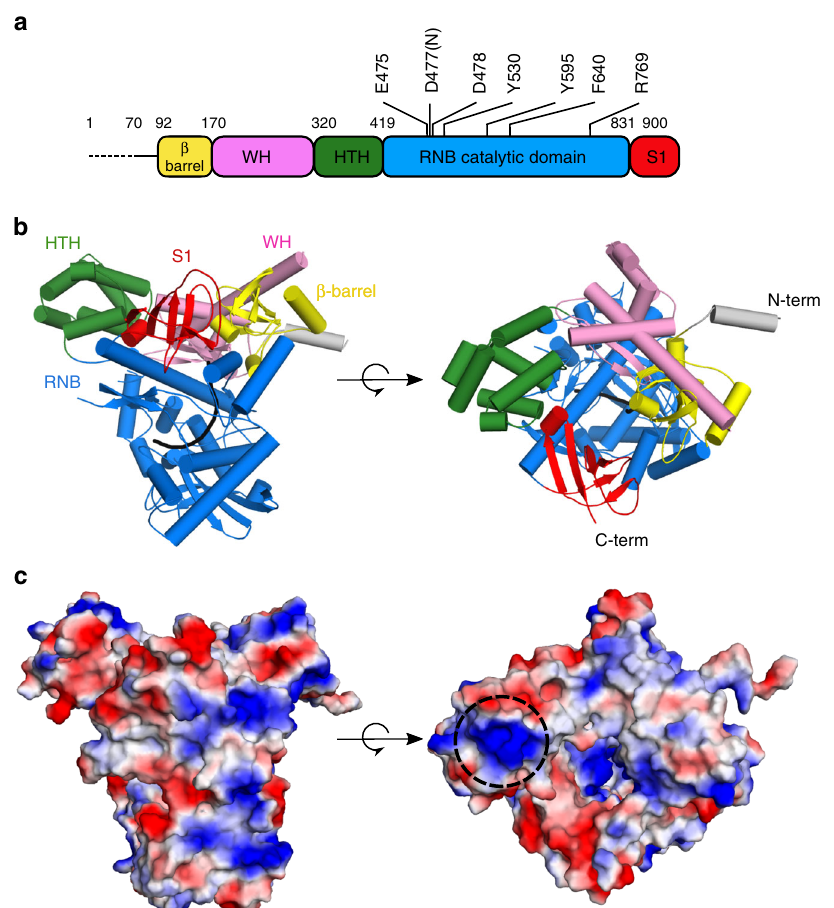
Fig. 1 Crystal structure of C. glabrata Dss1 70 – 900 D477N. a Schematic of the domain composition of Cg -Dss1. The domains are shown in colors: β -barrel in yellow; WH (wing-helix) in pink; HTH (helix-turn-helix) in green; RNB (nuclease domain) in blue; S1 in red. The dashed line corresponds to the region deleted in the crystallized variant. The positions of the residues of the RNB domain that are involved in RNA binding and degradation are indicated. b Overall structure of Cg -Dss1 70 – 900 D477N. The domains are colored as in a . The co-crystallized RNA molecule is shown in black. c Electrostatic surface potential of Cg -Dss1 70 – 900 D477N generated in PyMol (positively charged regions in blue, negatively charged regions in red, ± 65 kTe − 1 ). A positively charged patch located in the HTH domain is indicated by the dashed